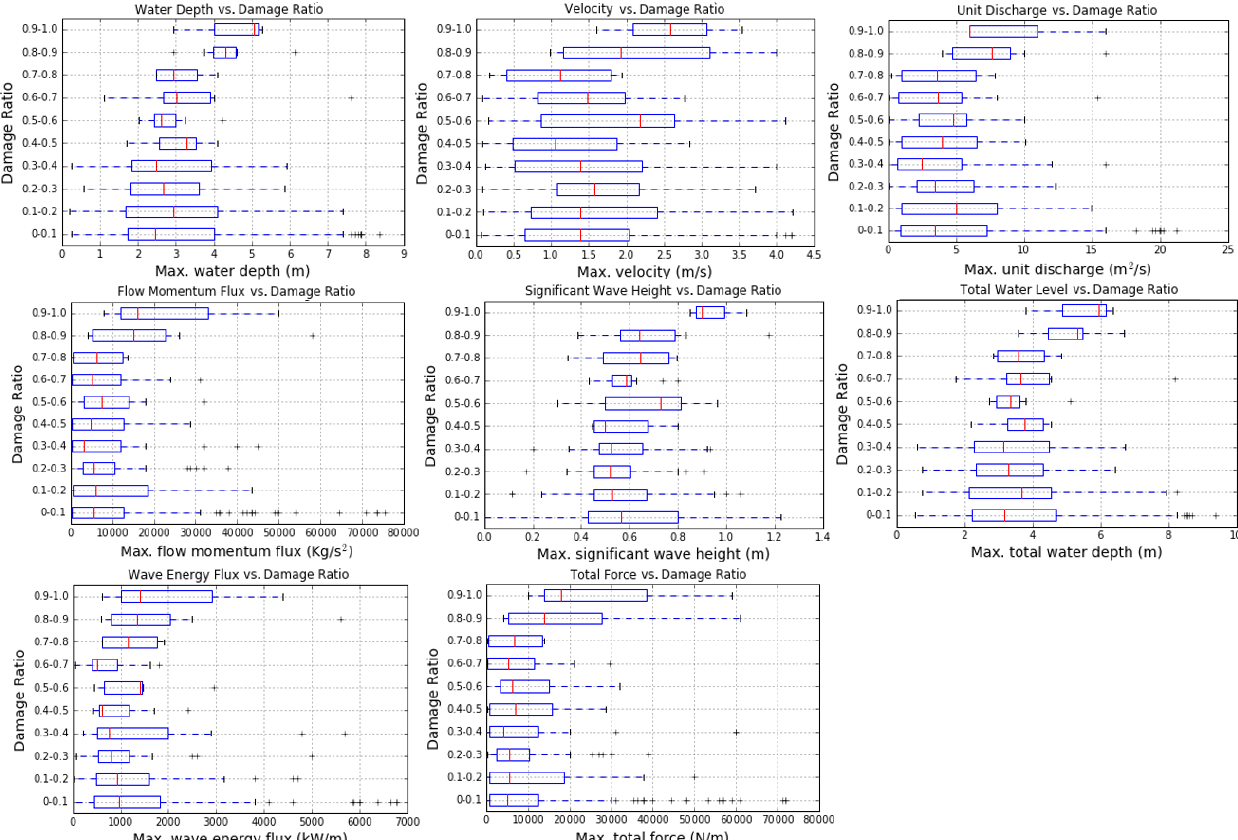
Figure B1. Comparison of three typical statistical distributions used for damage function development. The points correspond to the observed data and lines the different statistical distributions.